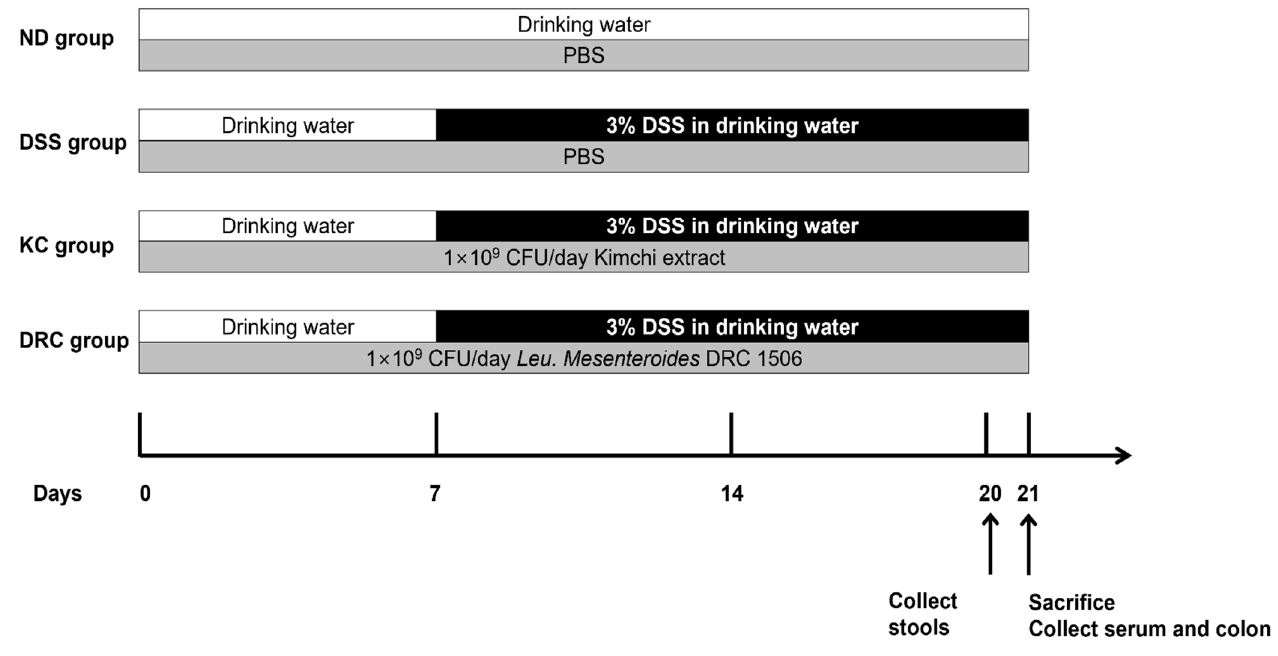
Figure 1. Experimental scheme showing the treatment period of DSS and samples. Samples were treated for 21 days. Except for the ND group, all other groups were given 3% DSS of drinking water starting on the 7th day after the study began. ND, normal group; DSS, DSS-treated group; KC, DSS + 1 × 10 9 CFU/day/mouse of kimchi group; DRC, DSS + 1 × 10 9 CFU/day/mouse of Leu. mesenteroides DRC 1506 isolated from kimchi.